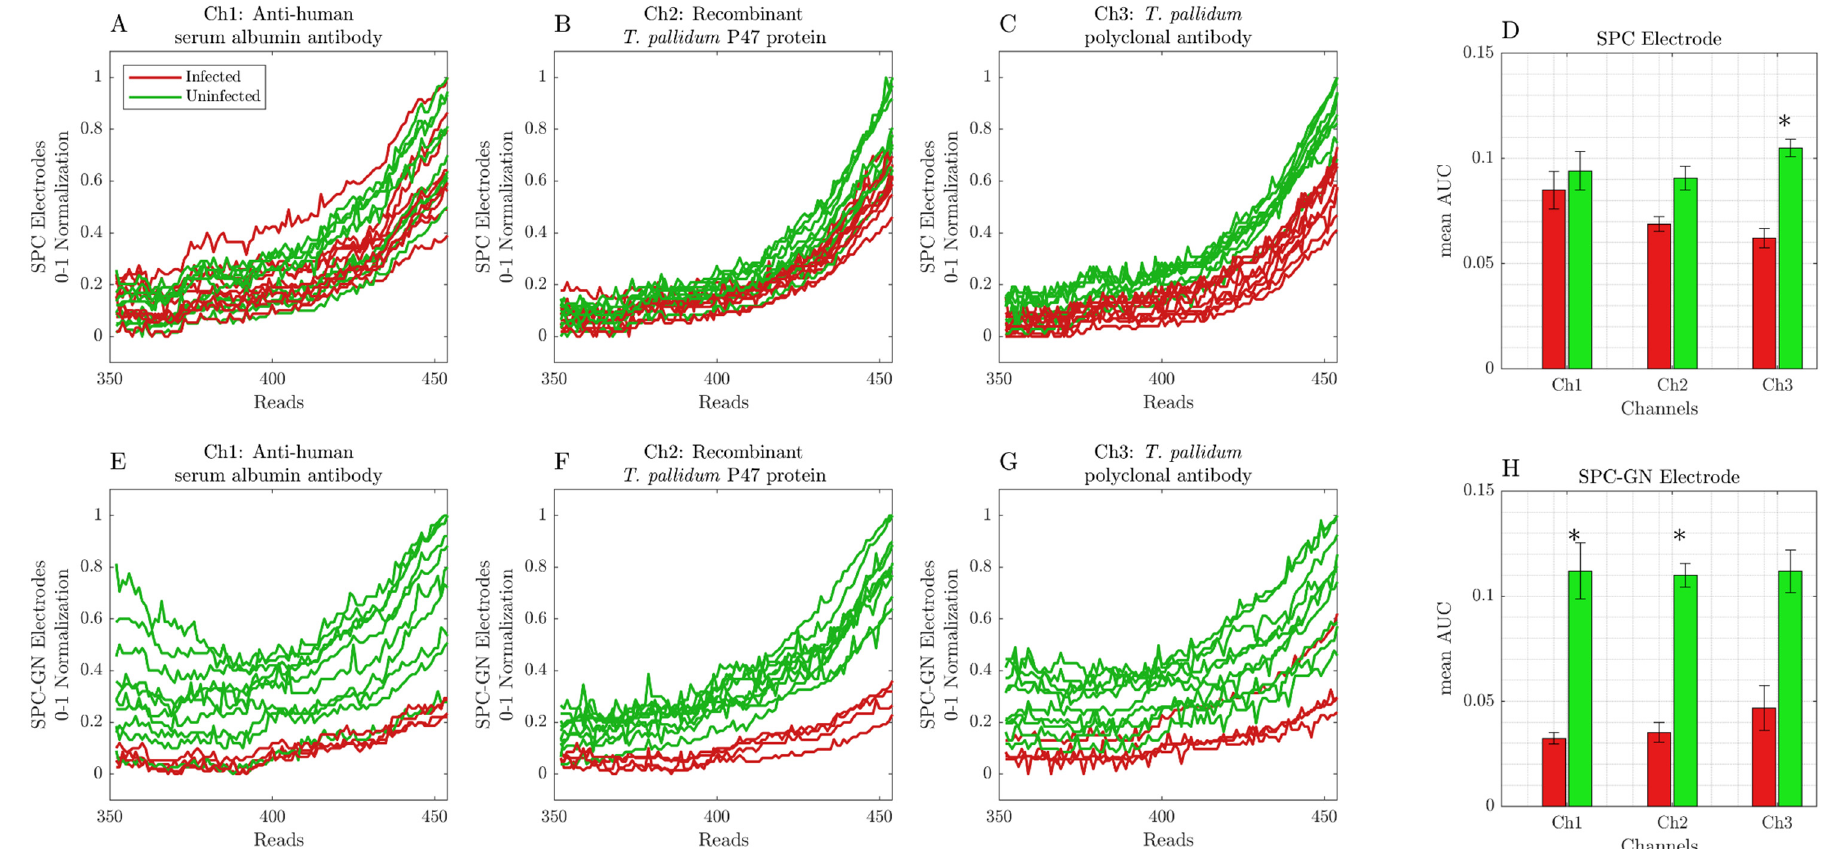
Figure 3. Cyclic voltammetry data were obtained from readings 15 min (T15 ′ ) after incubating infected and uninfected samples in SPC or SPC-GN electrodes. Each sample was submitted for 454 readings for each channel, with an interval of 9.25 ms. ( A ) anti-human serum albumin (Ch1) in SPC electrodes; ( B ) recombinant T. pallidum p47 protein (Ch2) in SPC electrodes; ( C ) T. pallidum polyclonal antibody (Ch3) in SPC electrodes; ( D ) AUC data of infected and uninfected samples using SPC electrodes; ( E ) anti-human serum albumin (Ch1) in SPC-GN electrodes; ( F ) recombinant T. pallidum p47 protein (Ch2) in SPC-GN electrodes; ( G ) T. pallidum polyclonal antibody (Ch3) in SPC-GN electrodes; ( H ) AUC data of infected and uninfected samples using SPC-GN electrodes. The * indicates the differences that resulted statistically significant for the Mann–Whitney U test after Bonferroni correction (at significance level of α =0.05)